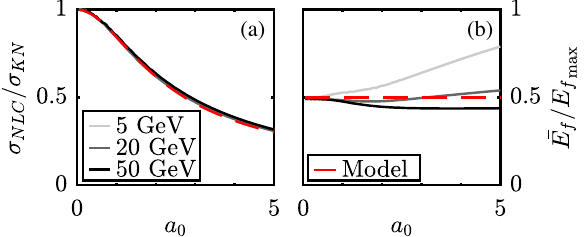
FIG. 3. Plot of (a) total cross section and (b) average photon energy calculated using [28] for the given electron energies. The approximation used in the simplified model is plotted as the red dashed line for